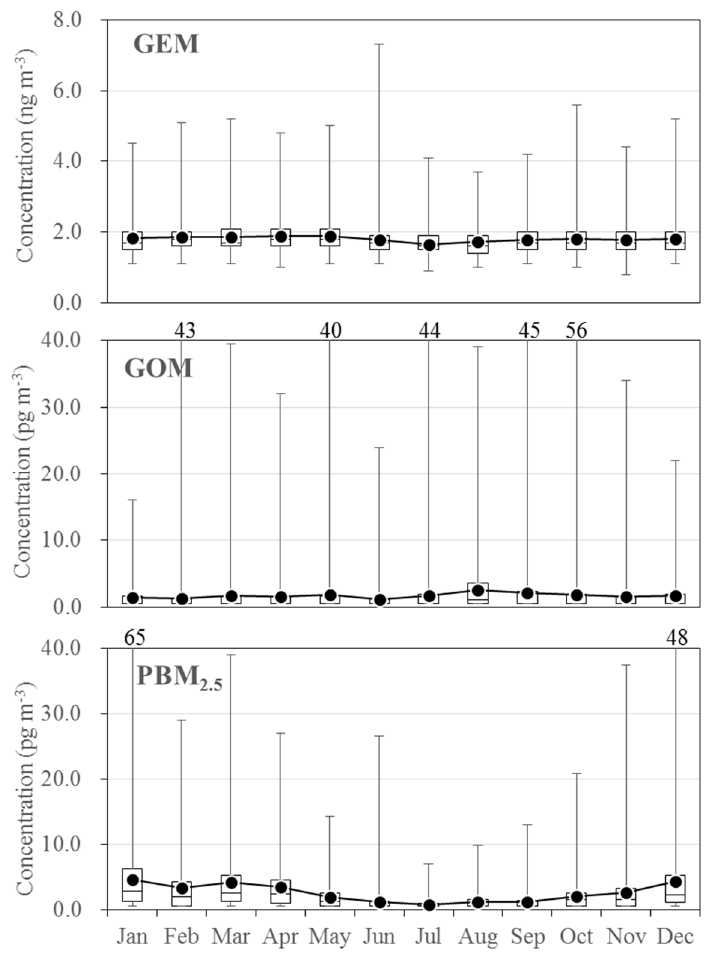
Figure 3. Box-whisker plots of the concentration distributions of GEM, GOM, and PBM 2.5 at Cape Hedo. The middle line in the box and the black circles shows median and mean concentrations, respectively. The box represents the range between the 25th and 75th percentiles and the whisker above and below indicates maximum and minimum concentrations, respectively. The numbers represent the maximum concentrations of GOM and PBM 2.5 in each month. Atmosphere 2019 , 10 , x FOR PEER REVIEW